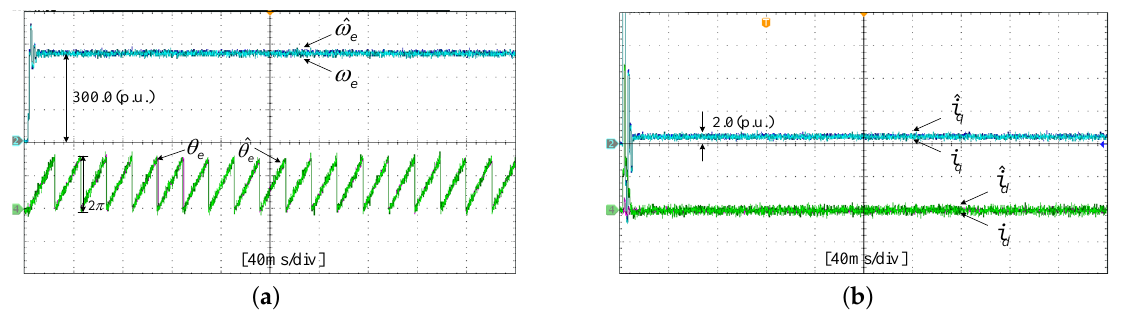
Figure 25. Experimental results of states and their estimated values. ( a ) States ω e , θ e and their estimated value ˆ ω e , ˆ θ e ; ( b ) states i d , i q and their estimated value ˆ i d , ˆ i q .